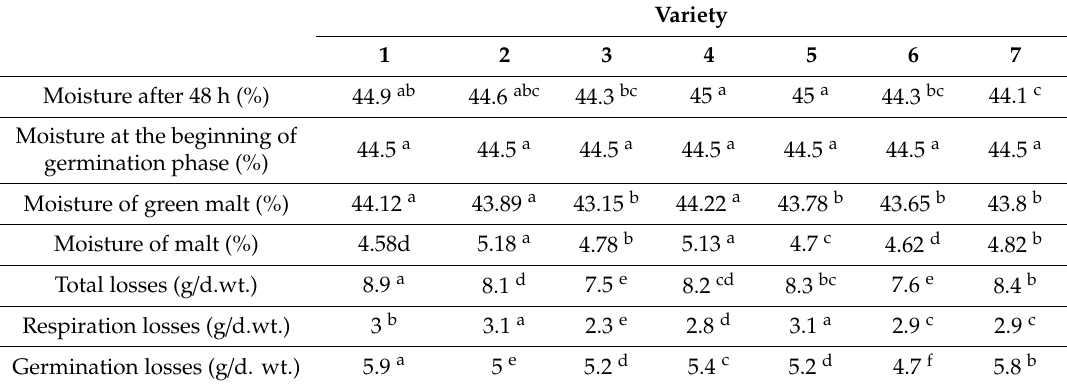
Table 3. Analysis of micromalting indicators (moisture and losses during malt